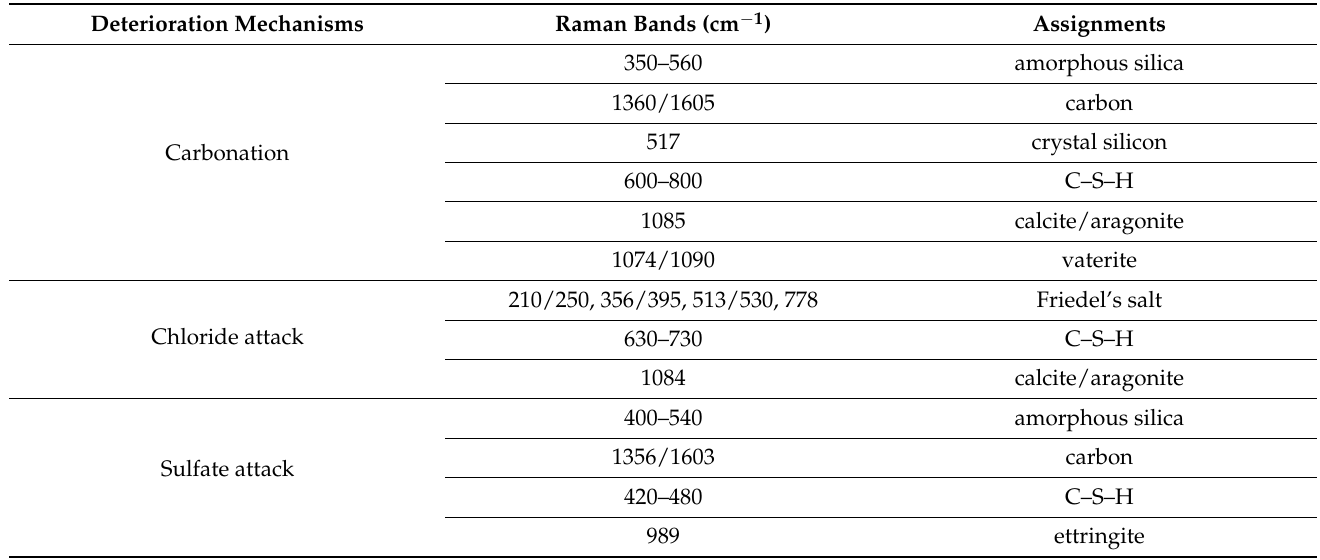
Table 2. Raman bands and assignments of SF–PC paste samples under different deterioration